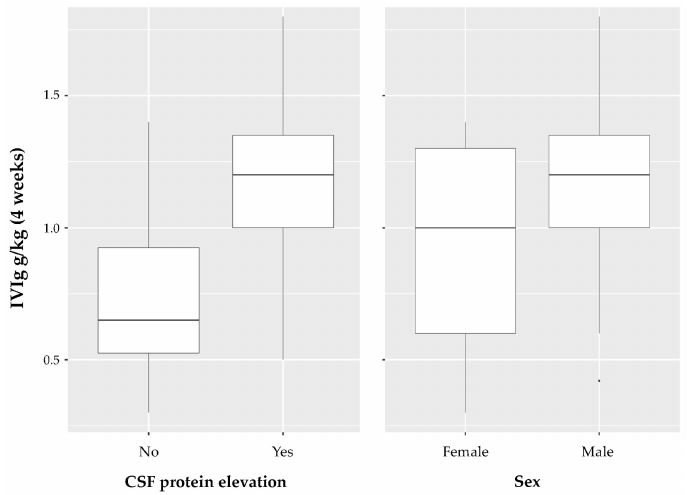
Figure 3. Box plot diagram for CSF protein elevation and sex. For the two characteristics (CSF protein elevation and sex) with the highest coefficients in the multivariabe regression model, a box plot diagram depicting the pattern of data distribution is